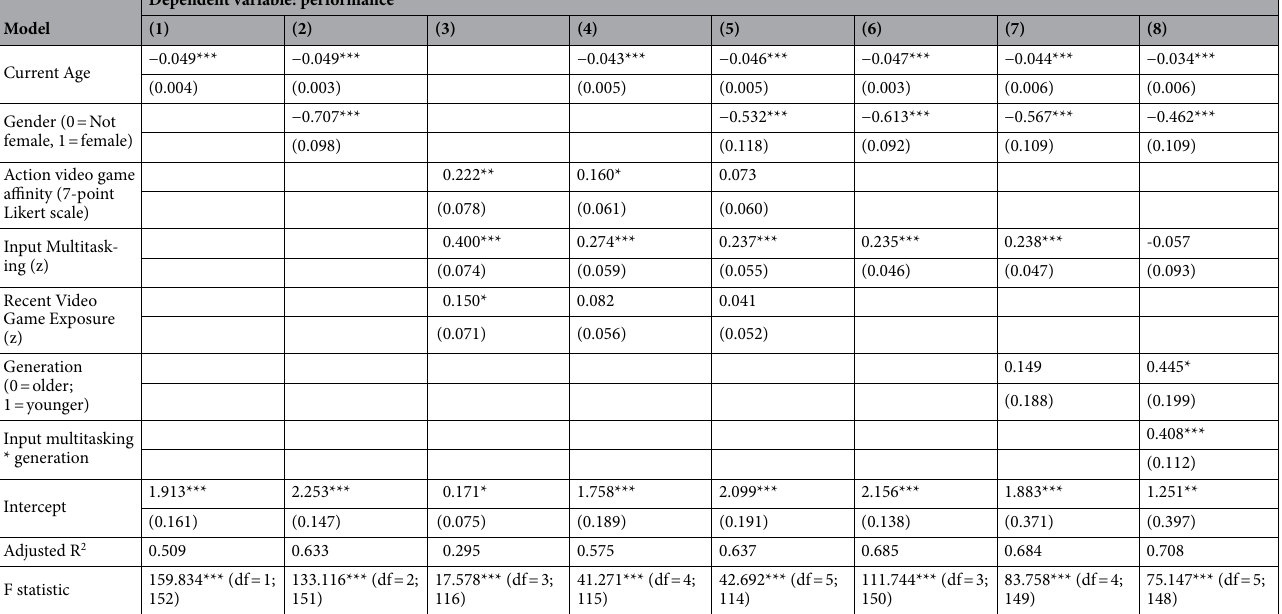
Table 2. Table of multiple linear regression models with in-game performance as the dependent variable (significance shown on regression coefficients with standard error in parentheses below; *p < 0.05, **p < 0.01, ***p < 0.001). Model 1 suggests that performance and age are associated, while Model 2 suggests that there is a gender gap in performance separate from age-related variance. Models 3–6 examine which measures— both in-game and external—provide information about prior video game exposure while controlling for age and gender. Models 7–8 suggest that the relationship between multitasking input and performance is vastly different between younger and older players. *p < 0.05; **p < 0.01; ***p < 0.001.